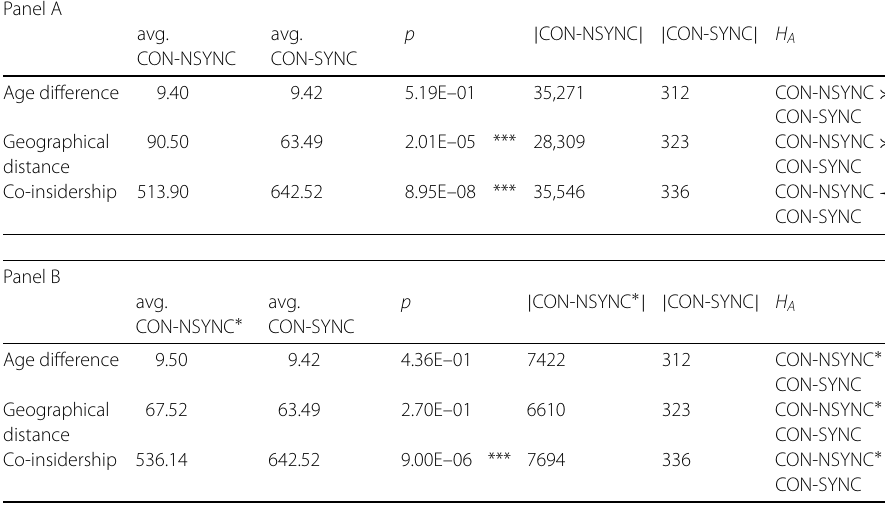
Table 3 One-sided Welch’s t -test on the difference in age, length of co-insidership and geographical distance between CON-NSYNC (Eq. (9)) and CON-SYNC (Eq. (8)) sets (Panel A), and CON-NSYNC ∗ (Eq. (10)) and CON-SYNC sets (Panel B). Trade synchronization between investors is validated at the significance level of α = 0.01. Here, H A is the direction of the alternative hypothesis. The units for the co-insidership are trading days, age difference in years, and geographical distance in kilometers Panel A avg. avg. CON-NSYNC CON-SYNC